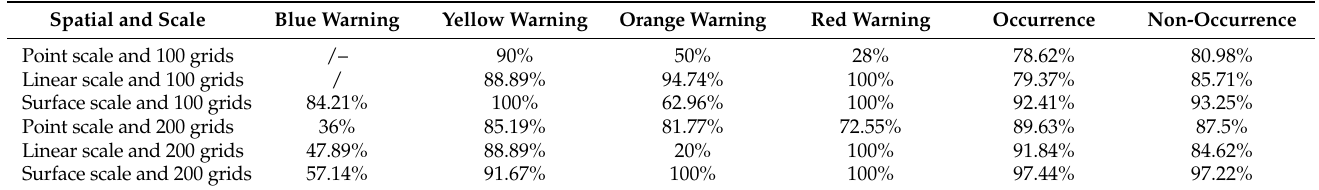
Table 5. The results of evaluation accuracy at different spatial scales with different